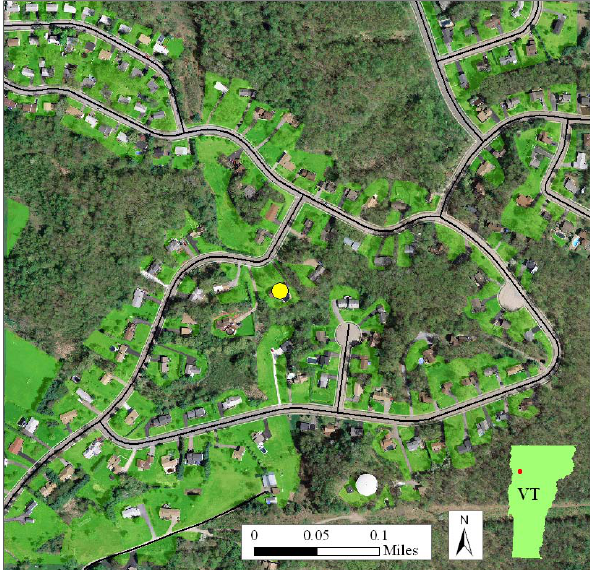
Fig. 1. Turfgrass (light green) in a suburban neighborhood in Es- sex, VT, comprises 28% of the total land cover (131 acres), the mowing of which releases a complex profile of unsaturated GLVs, which upon ozonolysis have the potential to contribute to atmo- spheric SOA. The study site (44.487653, − 73.09365) denoted by yellow